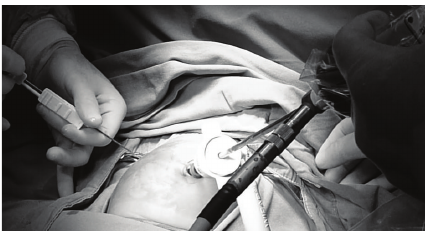
Figure 4: When the biliary ducts are patent, with the 18 G tru-cut biopsy needle, liver biopsy is taken under the vision of